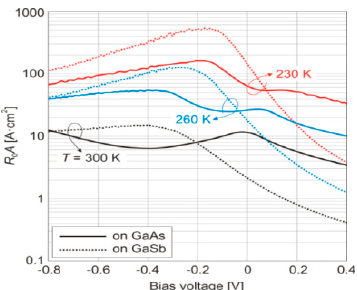
Figure 2. R 0 A product characteristics versus bias for T2SLs based ICIPs grown on GaSb and GaAs substrates.